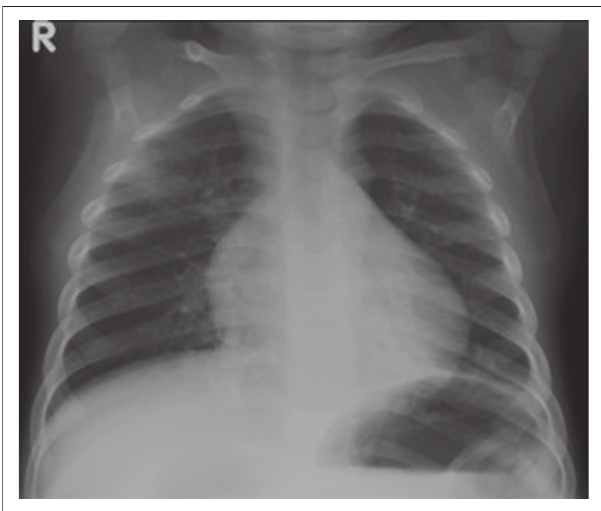
FIGURE 1: Chest radiograph on admission, with features of bilateral pneumonia.